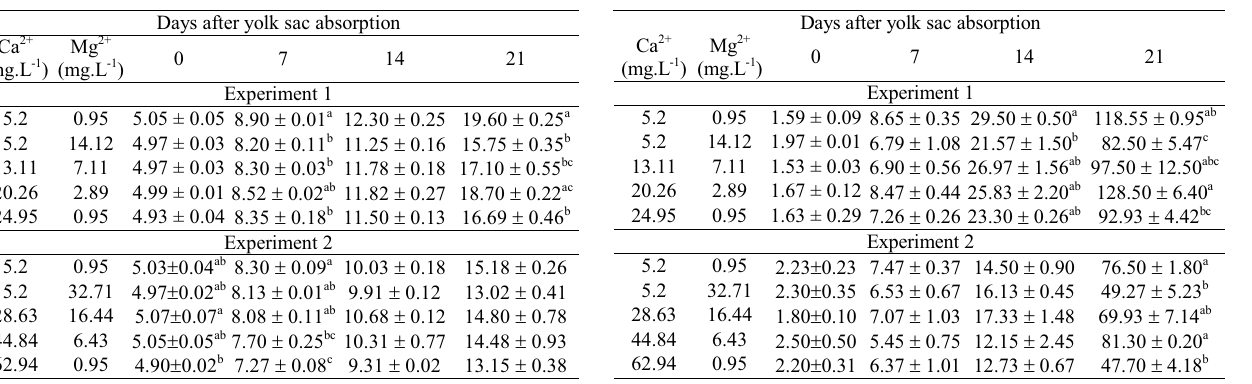
Table 3. Length (mm) of silver catfish larvae as a function of Ca 2+ and Mg 2+ concentrations in the water. Means (±SEM) with different letters in the same column and experiment are significantly different (P < 0.05) as determined by ANOVA and by the Tukey test. First line of each experiment is the treatment with water hardness of 20 mg.L -1 CaCO